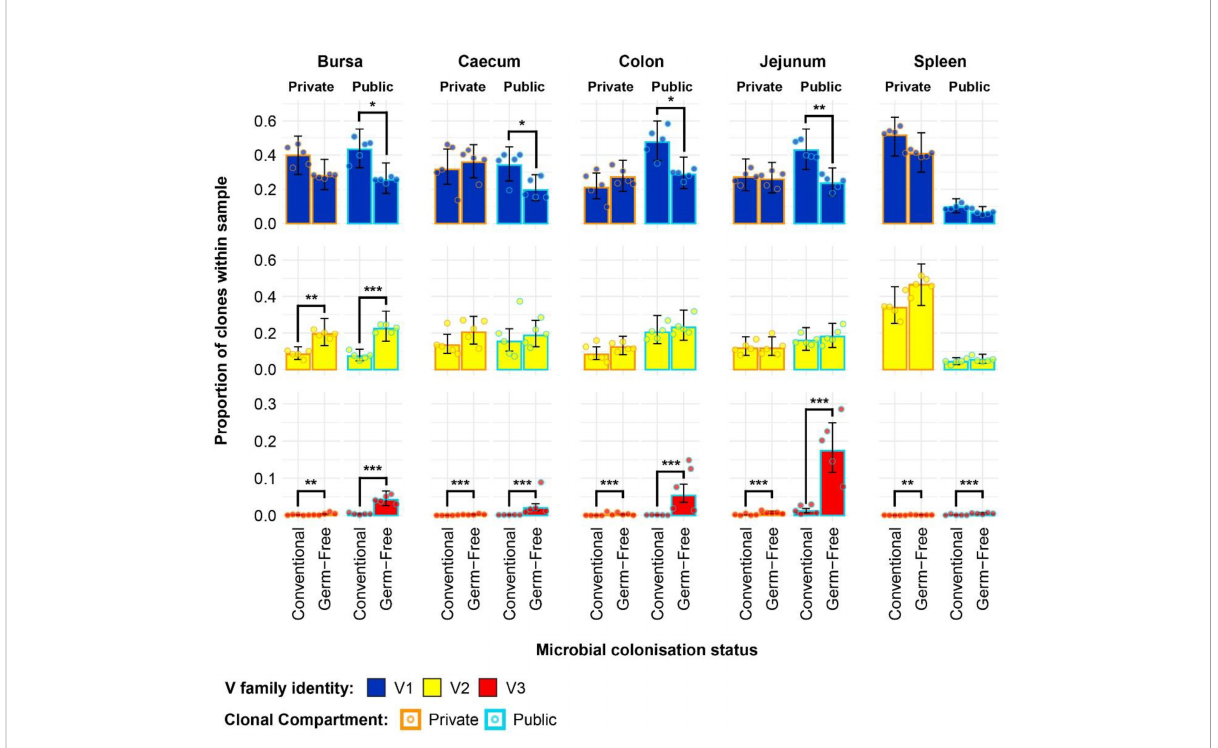
FIGURE 8 TCR b clone V family publicness in individual tissue samples across treatment groups. V family identities are shown in blue (V b 1), yellow (V b 2), and red (V b 3). Private (individual-restricted) clones have an orange outline. Public clones which are shared between more than two individuals have a light blue outline. Dots represent individual bird observations of V family contributions to the public and private clonal compartments. Error bars represent 95% bootstrap con fi dence intervals for the point estimates generated from 1000 simulations of the model. Statistically signi fi cant differences between the model estimates are depicted above the plots based on their corresponding p-values: *p < 0.05; **p < 0.01, ***p <